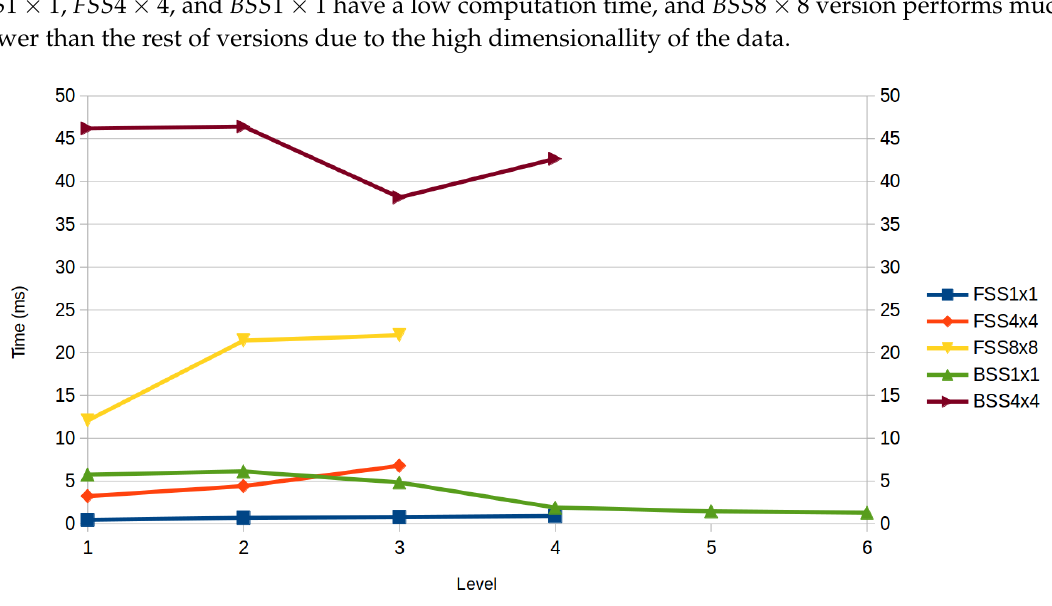
Figure 8. Times to classify an image with the different Subset selection methods on each level. The times on this Figure correspond to the average time that the classifier needs to classify an image using each descriptor on that level. The times of the BSS 8 × 8 are not shown since its values are around 200 ms and distorts the